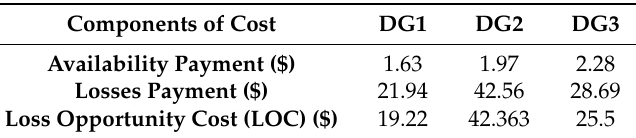
Table 8. The break-down of the QPF of DGs in Scenario